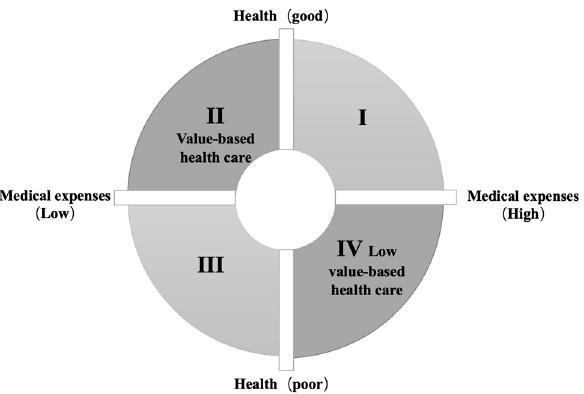
Figure 1. Four-dimensional figure illustrating the interactions between health and medical expenses. Note: In the second quadrant, low medical expenses and high levels of health reflect value ‐ based health care. High medical expenses and low levels of health reflect low ‐ value ‐ based healthcare.